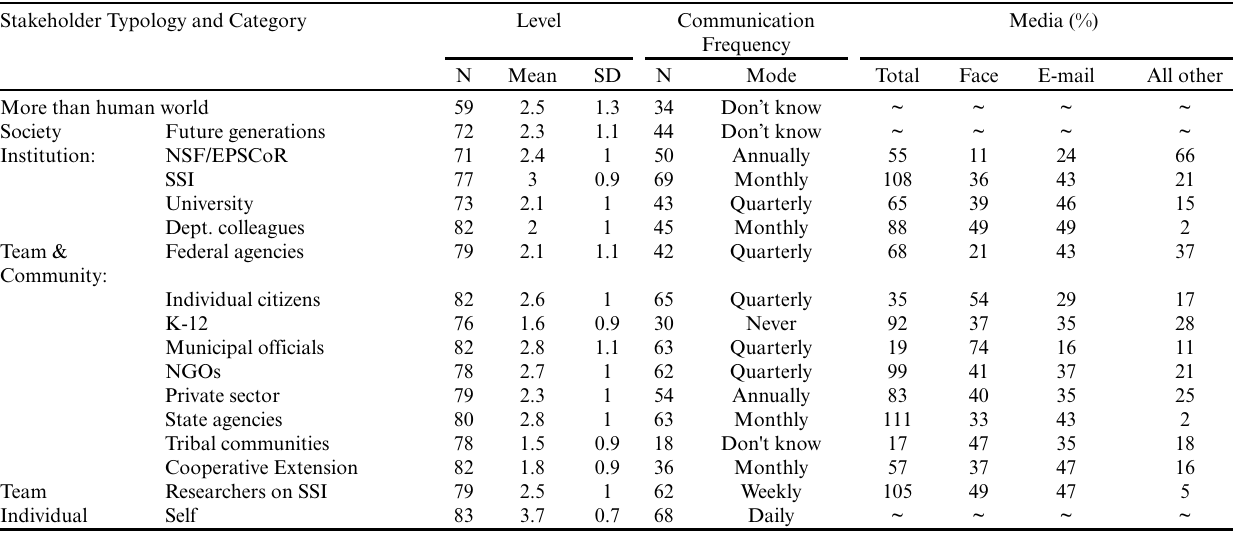
Table 2 . Degree of participation by stakeholder typology and category, level of involvement (1 = Not involved, 2 = Somewhat involved, 3 = Involved, 4 = Very involved), frequency of contact, and communication media (“all other” includes video, phone, and/or conference call, technical reports and/or newsletters, project or research web site, and